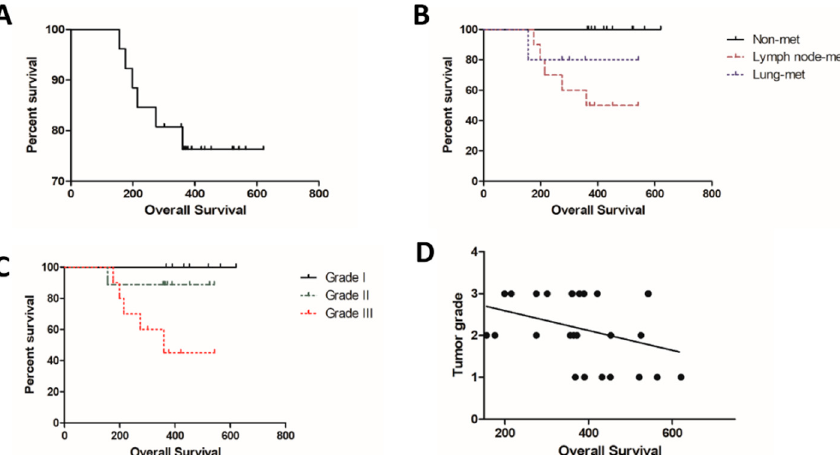
Figure 2. Overall survival of dogs with mammary carcinomas based on clinical parameters. ( A ) Percent survival of all female dogs independent of metastasis status. ( B ) Female dogs with nonmetastatic tumors exhibited increased survival time followed by patients with lung metastasis and lymph node metastasis. ( C ) Overall survival independent of metastasis status according to tumor grade. Patients with grade III experienced a reduced survival time. ( D ) Negative correlation between tumor grade and overall survival. Patients with low-grade tumors exhibited increased survival time.